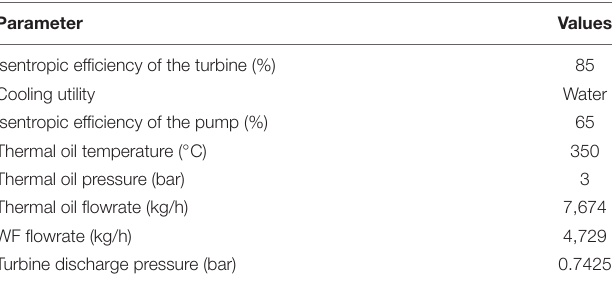
TABLE 2 | Design parameters of studied ORC